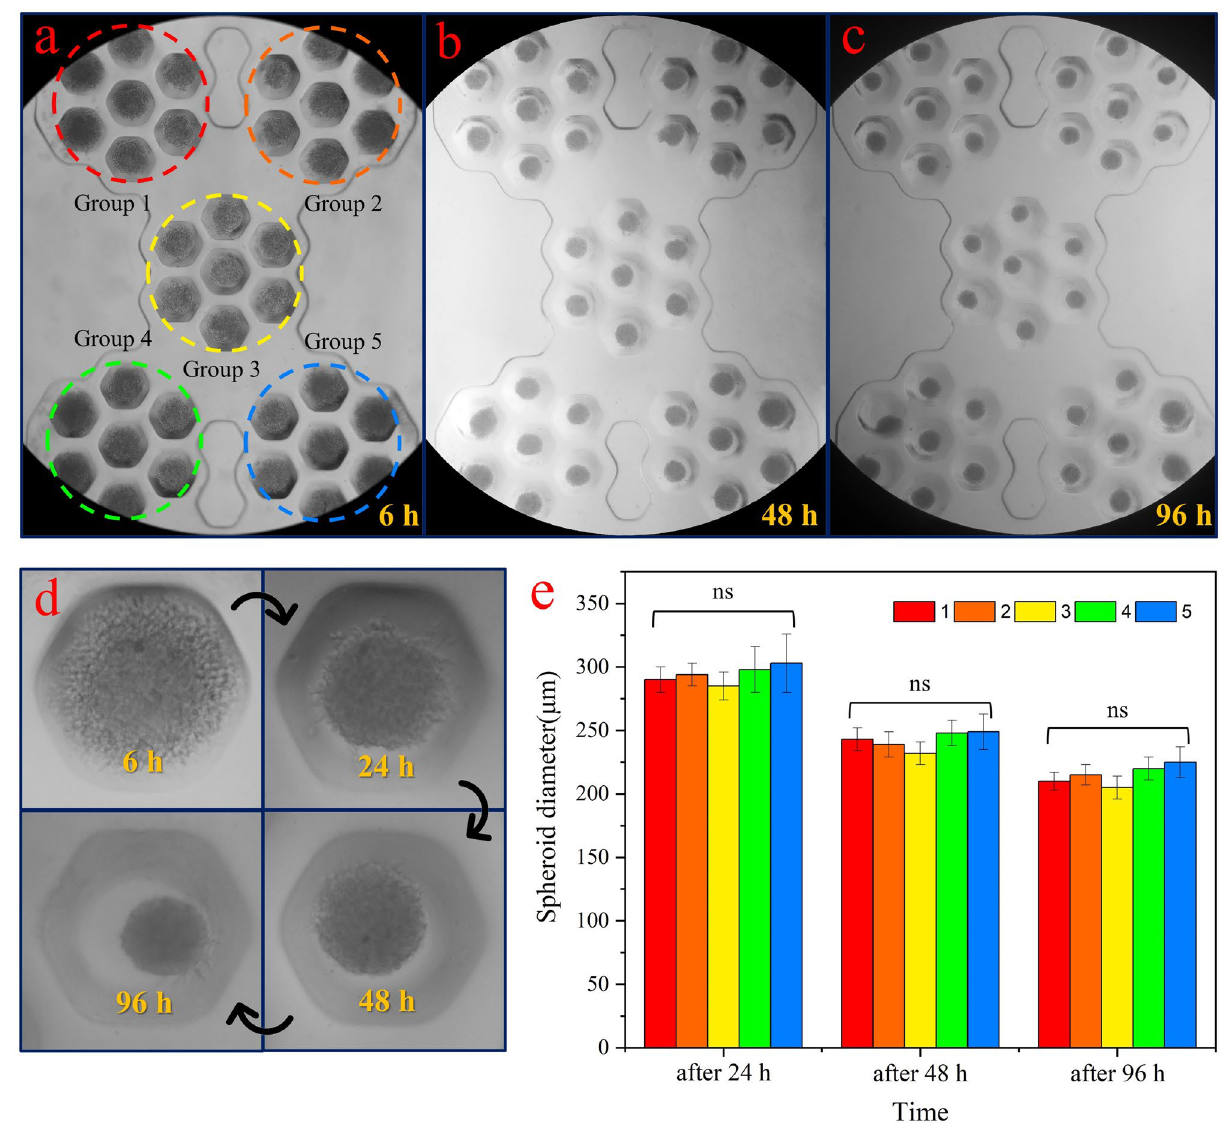
Figure 9. ( a – c ) The formation of a spheroid in microwells with a depth of 300 μm after 6 h, 48 h, and 96 h. In all microwells, the spheroid is formed. ( d ) Increment of the compactness of the spheroid for four days in a single microwell. ( c ) The diameter of the cultured spheroids for each group versus time. There is no significant difference in the diameter (ns) of the spheroid between these five groups of